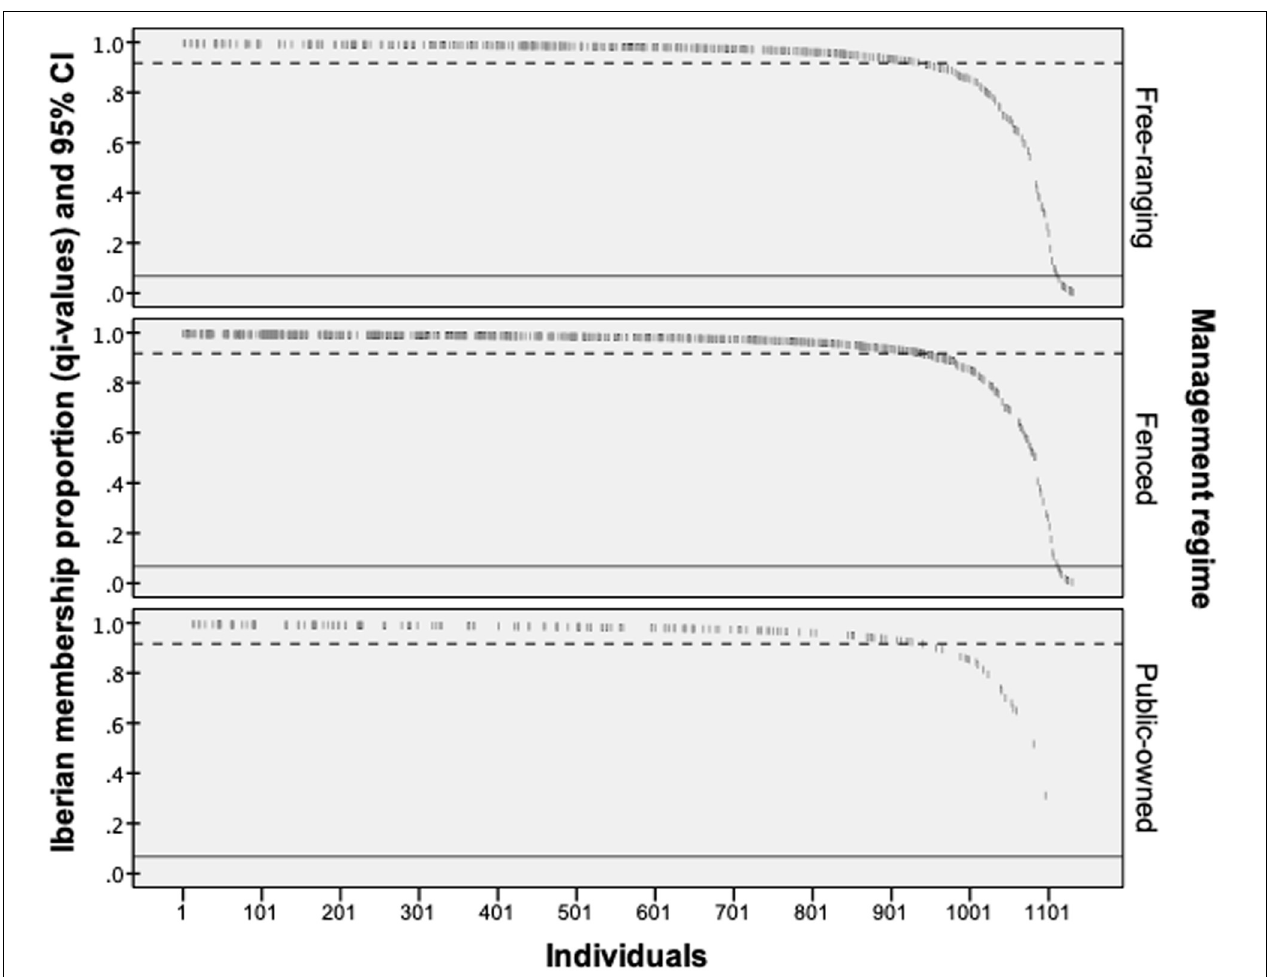
FIGURE 4 | The proportion of Iberian membership (qi-values) estimated in the STRUCTURE program for the 1,132 red deer sampled in the Iberian Peninsula. Dashed line indicates the threshold value (qi = 91,7%) used to consider native individuals (above line), while continuous line establishes the limit (6.72%) between non-native (below) and hybrid (above) classes.